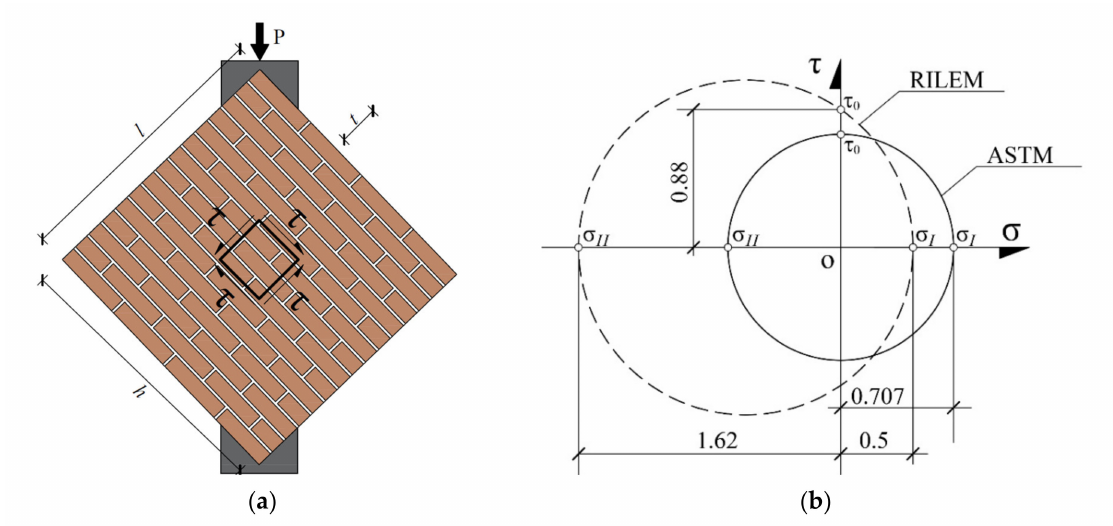
Figure 1. ( a ) American standard (ASTM) interpretation of the diagonal compression test; ( b ) Mohr’s circle corresponding to ASTM and RILEM interpretation of diagonal compression